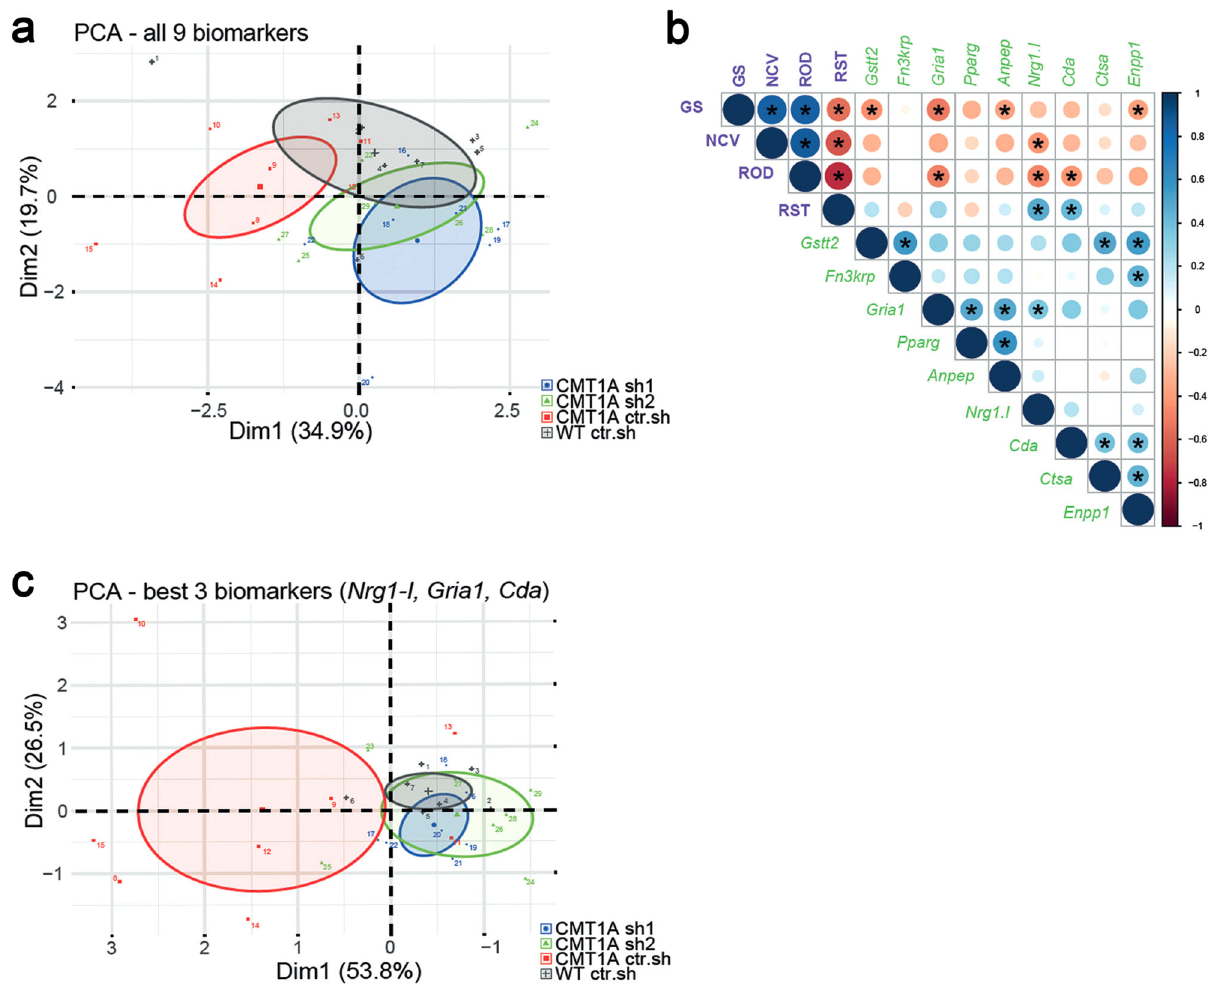
Fig. 6 Multi-variated analysis of skin biomarkers and sensory-motor phenotypes allows the detection of the therapy outcome. a Principal component analyses (PCA) of all nine transcriptional biomarkers in forepaw skin biopsies on twelve-month-old animals. Note little to no overlap between WT ctr.sh (gray, n = 7) and CMT1A ctr.sh (red, n = 8), whereas the treated groups, CMT1A sh1 (blue, n = 7) and CMT1A sh2 (green, n = 7), show more overlap with the WT ctr.sh group than with the CMT1A ctr.sh group. The mean of each group is given as a center point including the con fi dence interval (95%) given as an ellipse. b Correlation matrix from all animals (total n = 28 with n = 7 per group) including the expression levels of the skin biomarkers (green labels) and the four functional phenotypic analyses (purple labels): GS, grip strength; NCV, nerve conduction velocity; ROD, Rotarod; RST, Randall-Selitto test). Shown is data from a two-sided Pearson ’ s correlation analyses with graphical representation of the correlation coef fi cients, from red ( − 1) to blue ( + 1) (indicated by circle size and color), and the respective p- values (asterisks indicate p < 0.05, all the exact p -values are available in the Source Data File). c Principal component analyses (PCA) of the three best biomarkers ( Nrg1-I , Gria1 , Cda ; see correlation matrix in b ) in forepaw skin biopsies on twelve-month-old animals (same analysis as in a ). Source data are provided as a Source Data fi